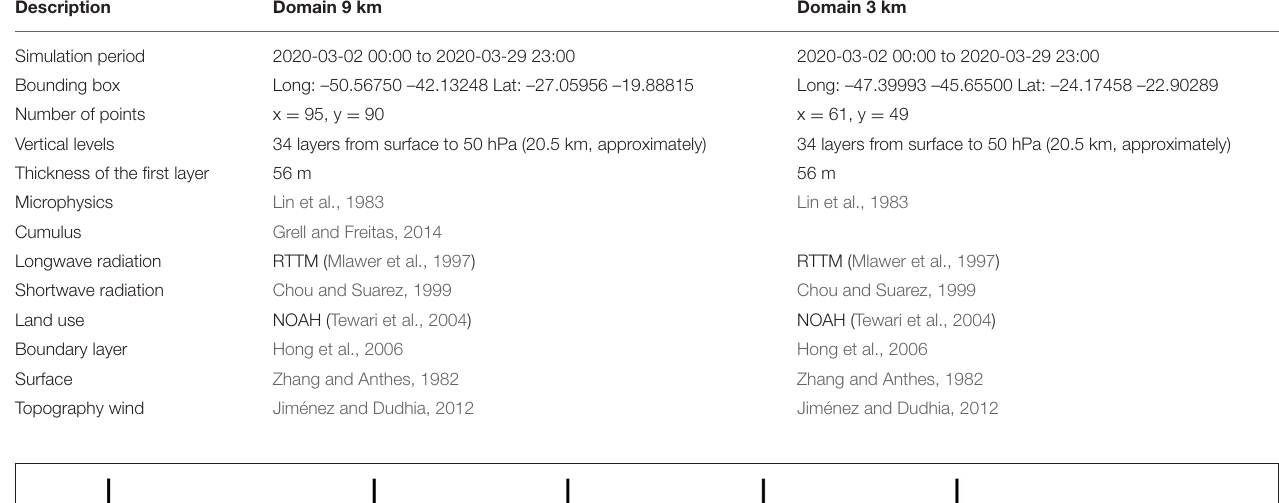
TABLE 1 | Model configuration for WRF-Chem.